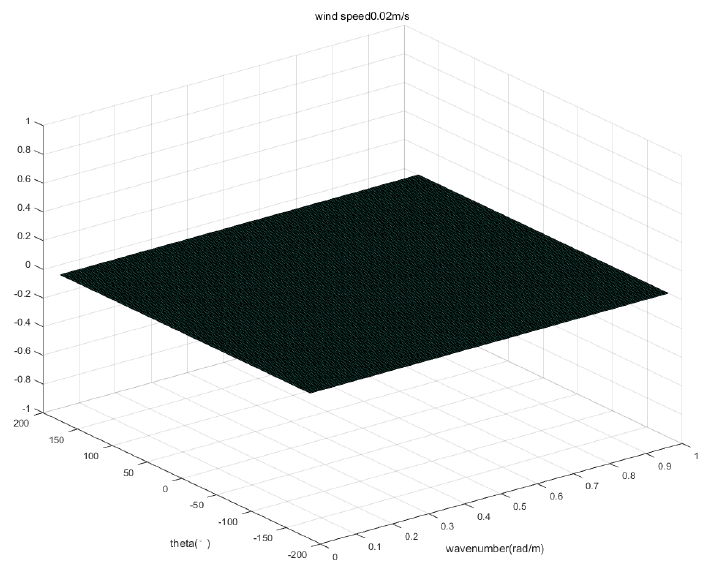
Figure 10. Two-dimensional wave spectrum with the measured wind speed.